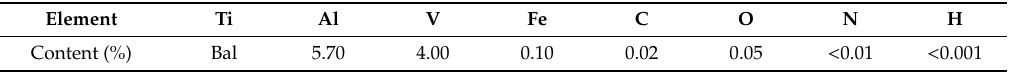
Table 1. Chemical composition of the Ti6Al4V titanium